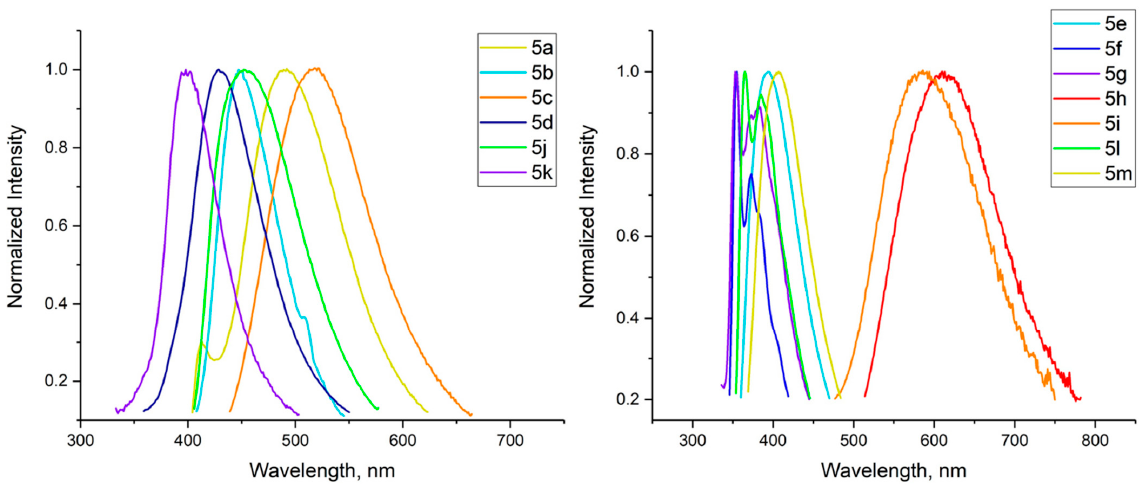
Figure 3. Emission spectra of 5a – d,j,k in THF (10 − 6 mol/L, left) and of 5e – i,l,m in THF (10 − 6 mol/L, right). right